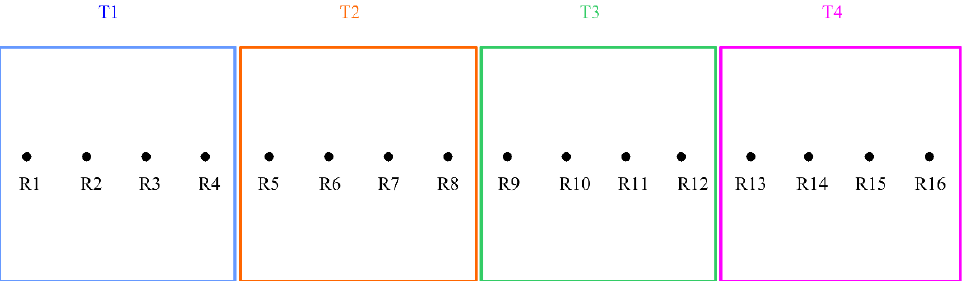
Figure 3. The TEM respones of the equivalent three-layer models. ( a ) The Central loop; ( b ) Offset = 80 m; ( c ) Offset = 120 m.